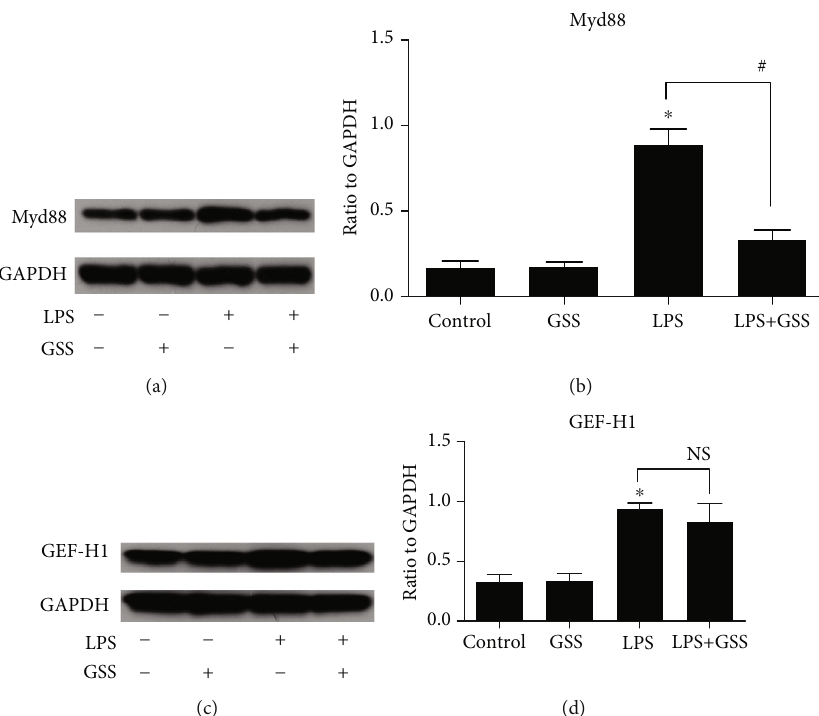
Figure 6: GSS block LPS-induced Myd88 expression in ECs. (a, b) ECs were incubated with GSS for 2 hours before LPS stimulation, and the expression of Myd88 was determined by Western blot. (c, d) ECs were pretreated with GSS for 2 hours followed by LPS stimulation, and the inhibitory e ff ect on GEF-H1 was determined by Western blot. ∗ P < 0 : 05 versus negative control. # P < 0 : 05 versus the corresponding LPS treatment group.